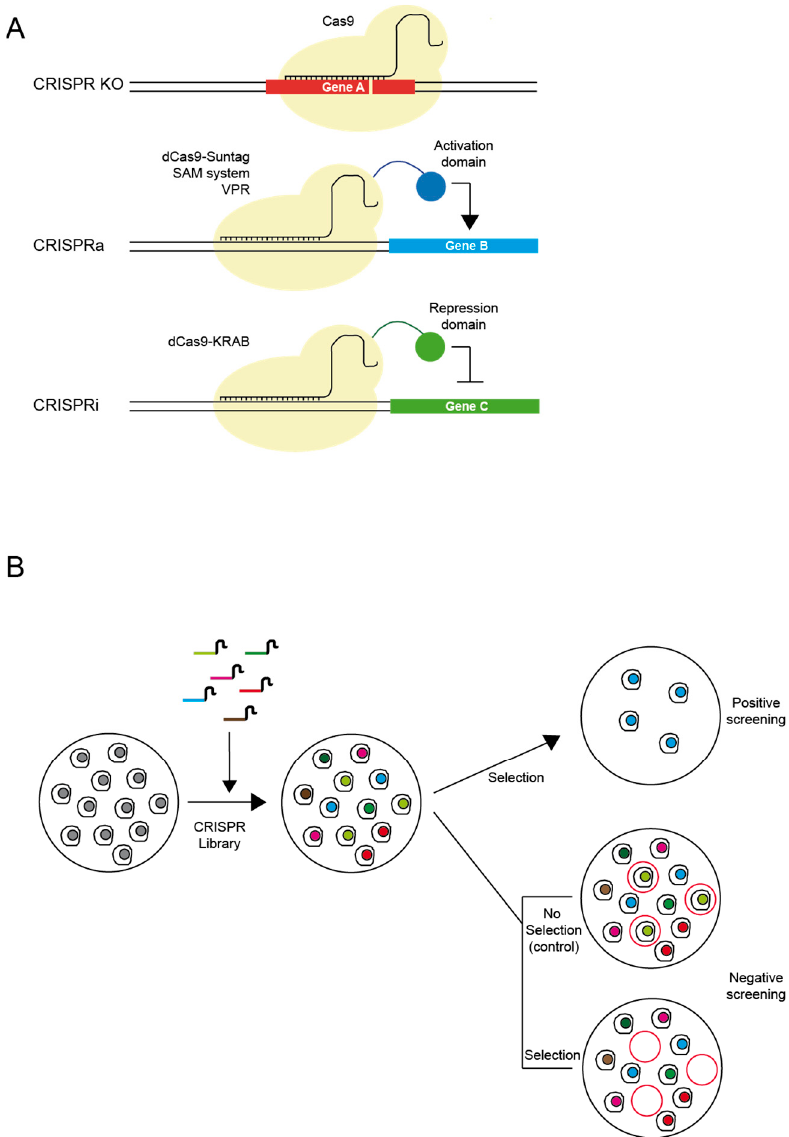
Figure 2. Principal applications of CRISPR used in drug discovery. ( A ) Three main approaches for transcriptional modulation: (i) CRISPR KO, to generate non-functional proteins or knock-outs of a specific gene by using wild-type CRISPR system; (ii) CRISPR activation, to produce specific gene activation using a catalytically-inactive version of the Cas9 enzyme (dCas9) fused to different activator domains (e.g., SunTag, SAM, VPR); (iii) CRISPR repression or inactivation, by fusing repressor domains (e.g., KRAB) to the dCas9 protein. ( B ) Pooled high-throughput screening can be performed using genome-scale guide RNA libraries, either in a positive or negative selection manner.